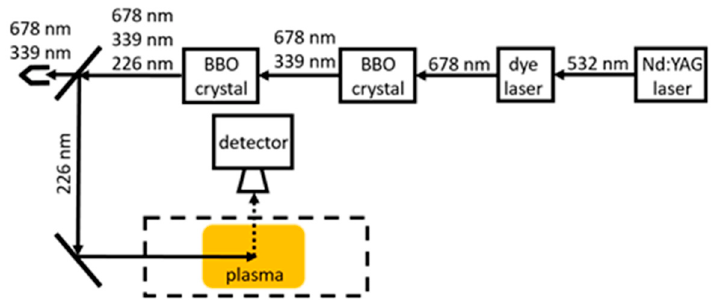
Figure 9. Schematic of a typical TALIF setup for measurements in oxygen plasma. Firstly, an Nd:YAG laser (in this case, with its second harmonic at 532 nm) is used to pump a continuum dye laser. This laser light is frequency doubled and tripled using two beta-barium borate (BBO) crystals. Lastly, the laser light is filtered and focused on the plasma, with the detector for the fluorescent light at a right